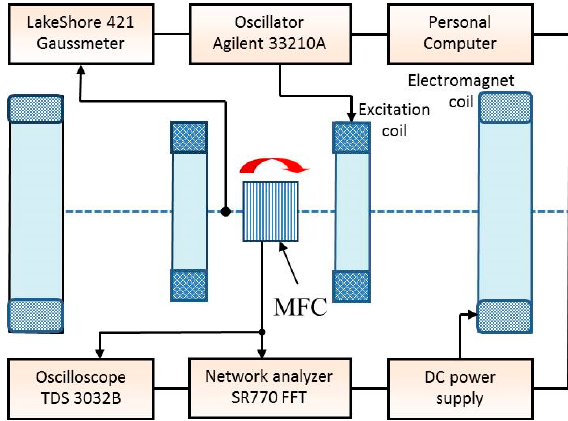
Figure 2. Schematic diagram of the experimental setup.